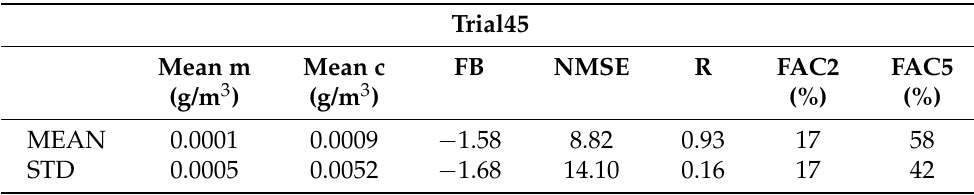
Table 8. Statistical analysis for the mean concentration and the concentration standard deviation in the unstable case trial 45. m indicates measured and c calculated.